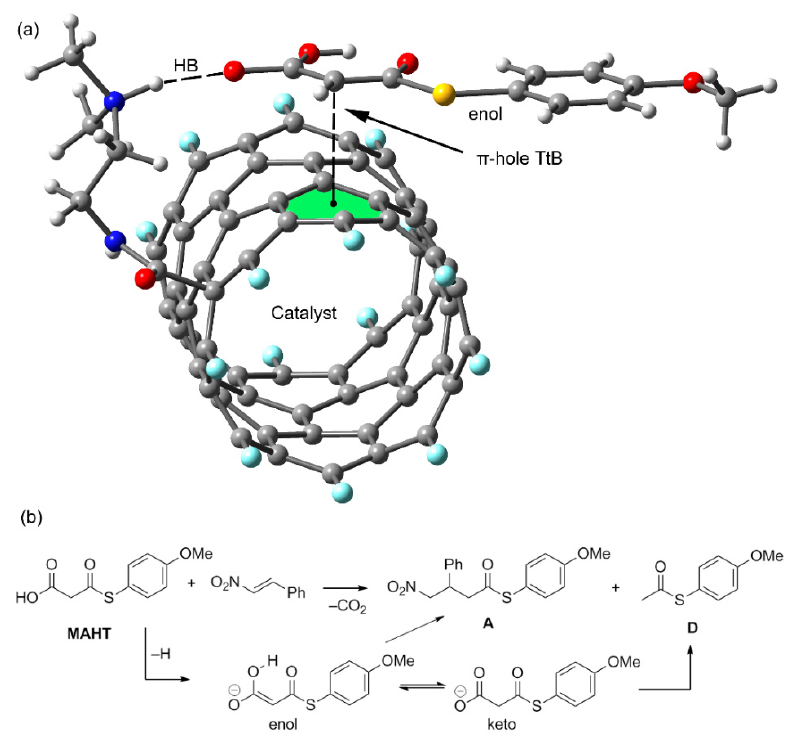
Figure 14. ( a ) Representation of a generic nanotube functionalized with a tertiary amine and a linker and interacting with MAHT interacting by a combination of HB and anion– π ( π -hole TtB); ( b ) Reaction of MAHT with β -nitrostyrene to yield the mixture of addition (A) and decarboxylation (D) products.